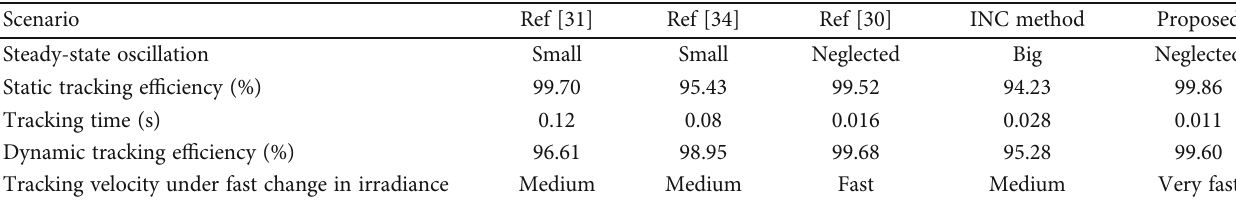
Table 5: Performance comparison of the proposed MPPT scheme with other MPPT